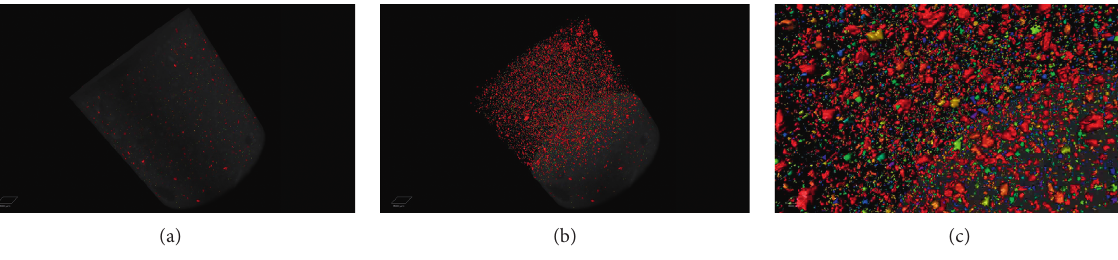
Figure 19: 3D reconstruction of NCG concretion by 3D-XRM. (a) Whole three-phase. (b) Pore-phase. (c) Pore-phase magnification.